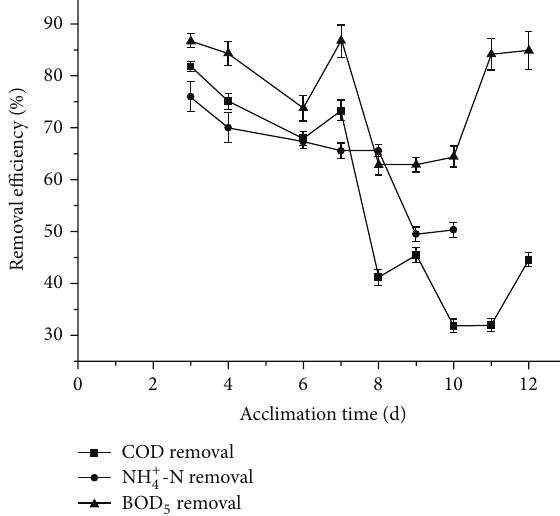
Figure 2: Changes of COD, NH + 4 -N, and BOD 5 removal efficiency over time and their standard